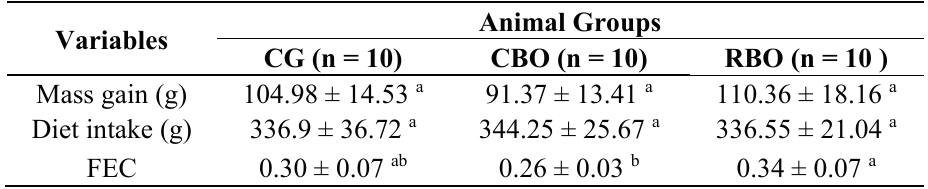
Table 1. Intake, weight gain and feed efficiency coefficient of Wistar rats fed with diets added of soybean oil or refined or crude buriti oil.